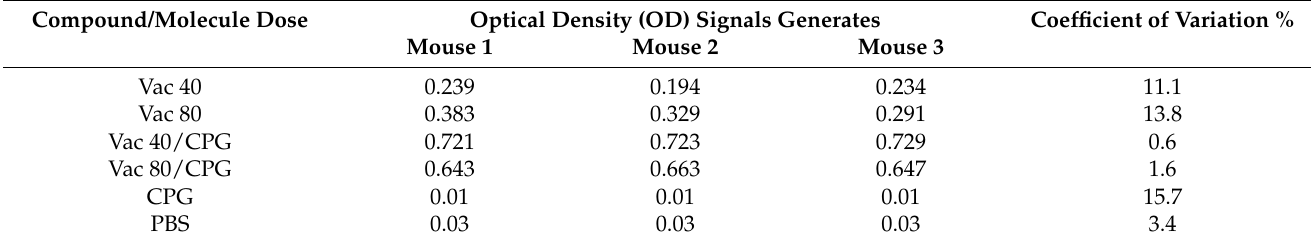
Table 4. Reliability of the vaccine concentrations among BALB/c mice at day 14. Compound/Molecule Dose